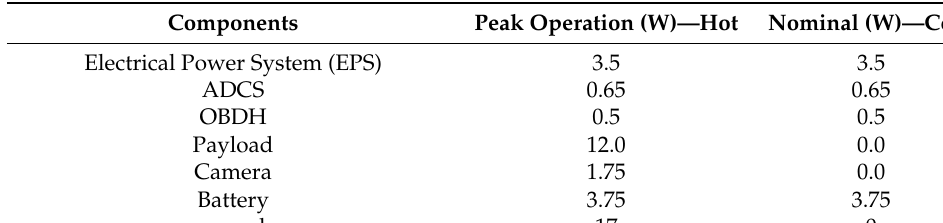
Figure 15. Satellite’s attitude in orbit—DR. Table 7. Thermal Model—Heat loads.